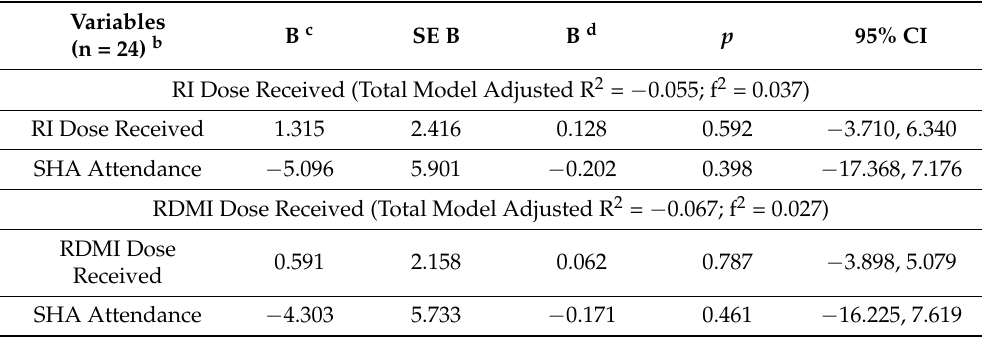
Table 3. Multiple Linear Regression for Measures of RDMI Use, Summer Harvest Adventure Atten- dance, and Changes in Child Skin